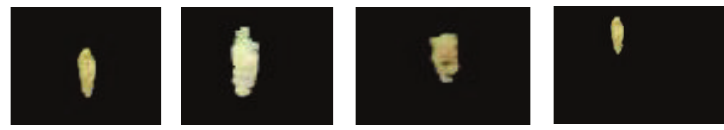
Figure 13: Brown spot samples.